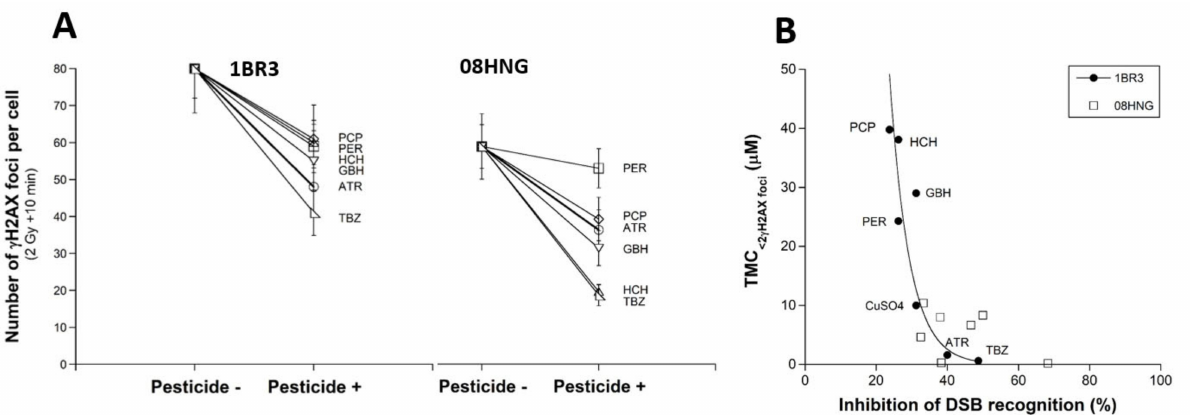
Figure 5. Power inhibition of DSB recognition of the pesticides tested. ( A ) The γ H2AX foci assessed 10 min post-irradiation shown in Figure 4 in the RIANS-normal (1BR3) and the RIANS-delayed 08HNG fibroblasts, with or without pre-exposure to pesticides (pesticide+ and pesticide-, respec- tively). Each plot represents the mean ± standard error (SEM) of three replicates. These data helped us to calculate the inhibition power of DSB recognition (see Materials and Methods). ( B ) The TMC >2 γ H2AX foci values deduced in the above chapters were plotted against the corresponding inhi- bition power of the DSB recognition for both 1BR3 and 08HNG cells. The 1BR3 data were fitted to the following formula: y = 3661.4 exp( − 0.1815x) (r = 0.87). The CuSO 4 data were taken from